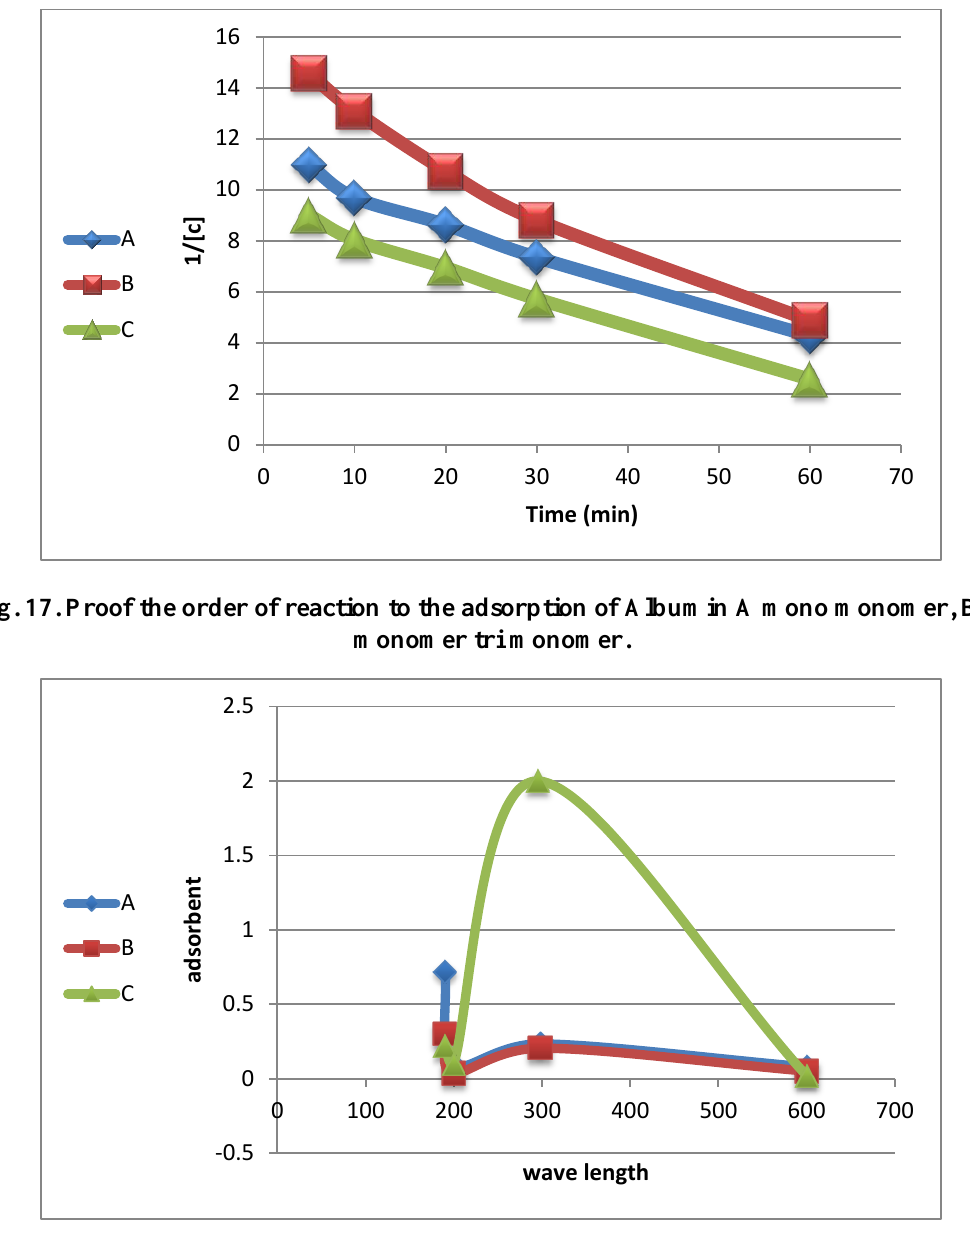
Fig. 18. The correlation between the wave length and adsorbent, A mono monomer, B di monomer tri